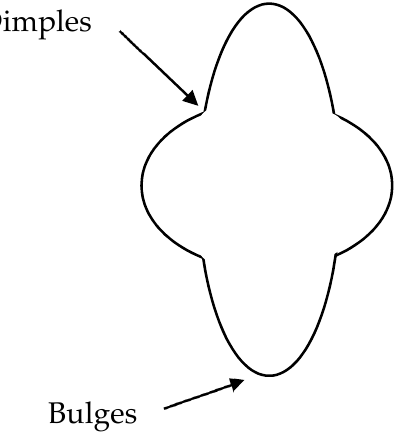
Figure 7. Idealized picture of the variation in thickness of the pattern formed by the evaporated droplet of the polyelectrolyte–surfactant mixture. The thickness of the deposit decreases from the edge (darker region) to the center (lighter region).